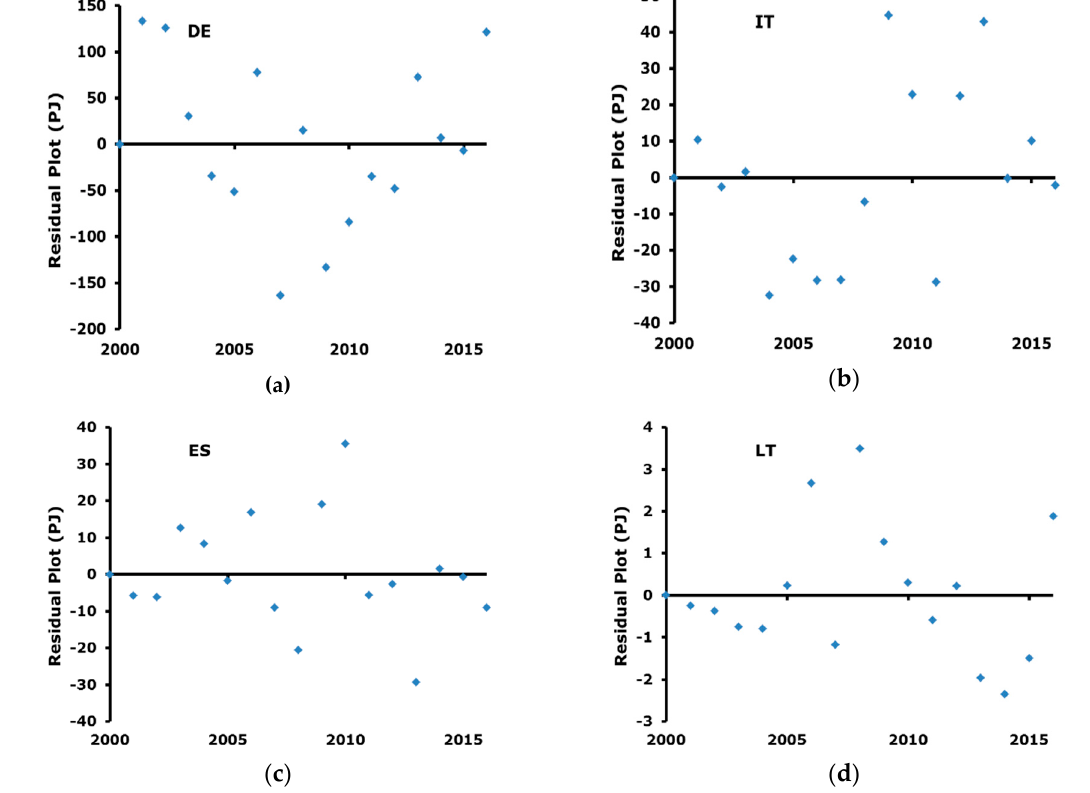
Figure 4. Residual plots for the considered countries: ( a ) Germany; ( b ) Italy; ( c ) Spain; ( d ) Lithuania.